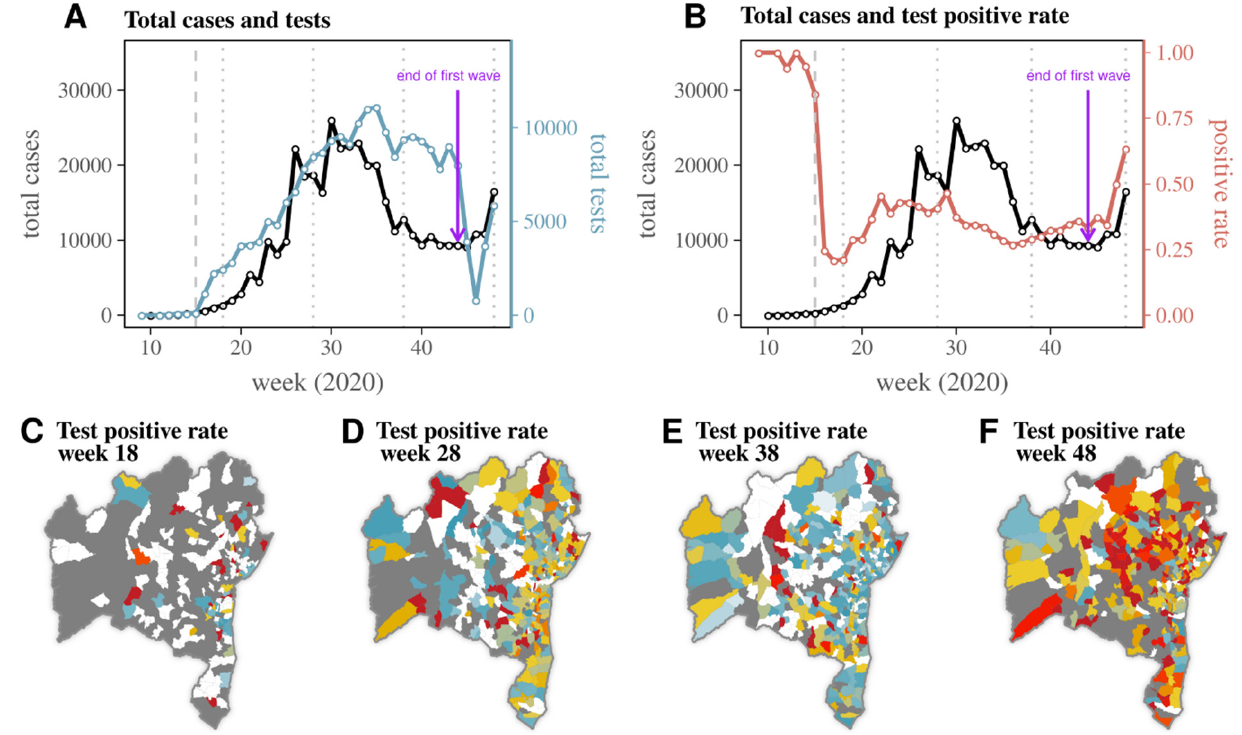
Figure 2. Reported SARS-CoV-2 cases and RT-PCR testing in Bahia during the first wave. ( A ) Total cases (black) and RT-PCR tests (blue) per week in Bahia. ( B ) Total cases (black) and positive rate (red) per week in Bahia. ( A , B ) Purple arrow marks the first week of November 2020 when daily incidence (Figure 1B) presents a trough indicative of the end of the first epidemic wave in the state. The dashed grey line marks week 15, before which the positive rate is artificially high due to low number of tests performed. ( C – F ) Mapping of positive rate (PR) per municipality in Bahia for ( C ) week 18, ( D ) week 28, ( E ) week 38, and ( F ) week 48. These weeks are marked in panels ( A , B ) as vertical dotted lines. Municipalities with no tests are coloured in grey, while those with tests are coloured according to scale on the far right.